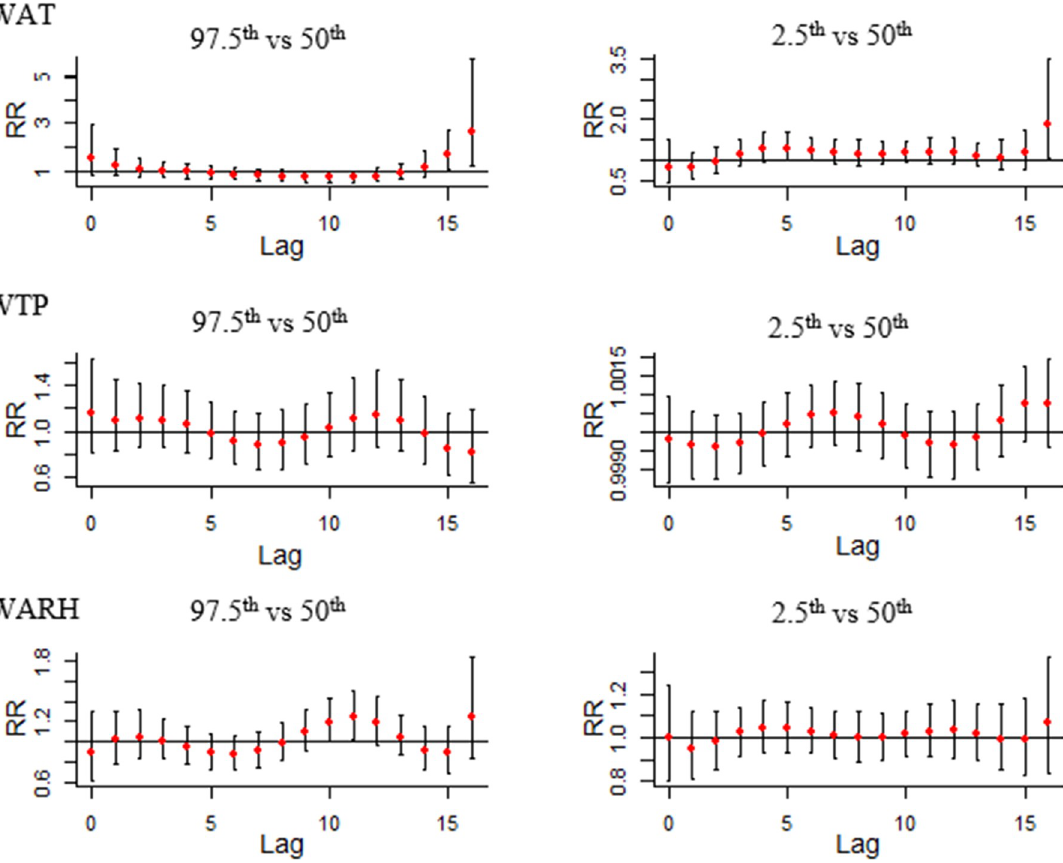
Fig 4. The lag effect between WAT, WTP, WARH, and HFRS infection (Abbreviations: RR, relative risk; WAT, weekly average temperature; WTP, weekly total precipitation; WARH, weekly average relative humidity).